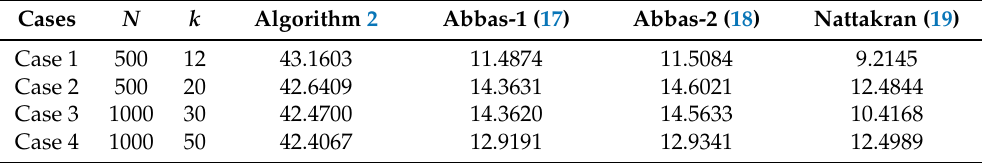
Table 2. SNR comparison results between Algorithm 2, Abbas-1 (17), Abbas-2 (18), and Nattakran